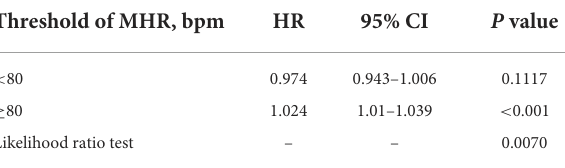
TABLE 3 Threshold analyses of MHR on 30-day mortality using two-piecewise regression